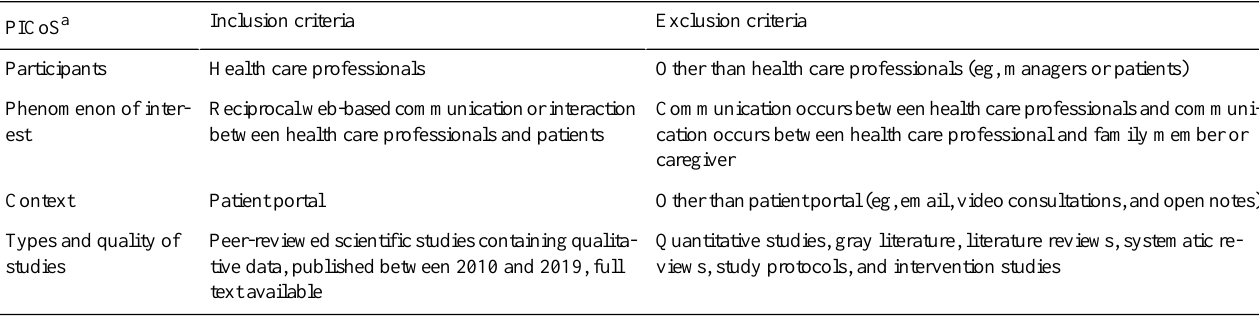
Table 2. Eligibility criteria according to the PICoS